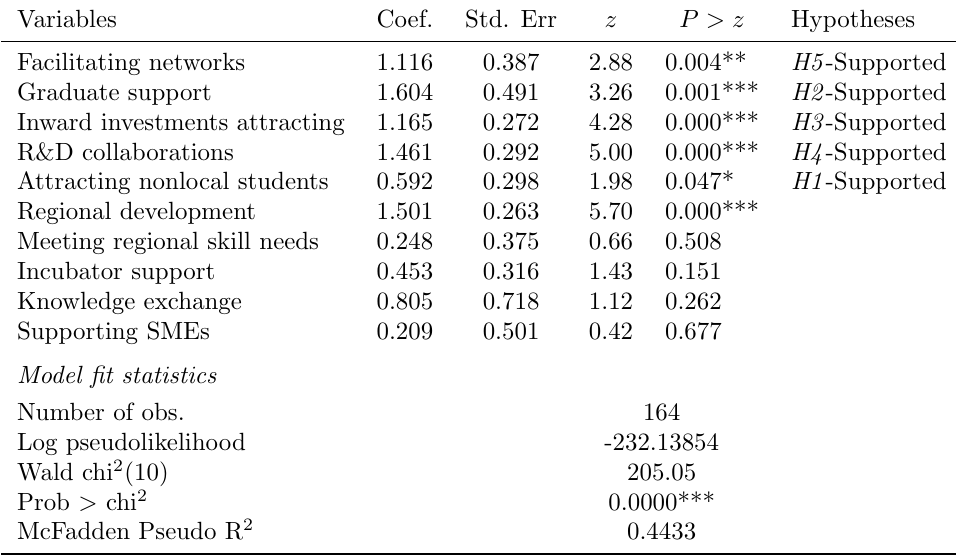
Table 3: Results of the logit regression